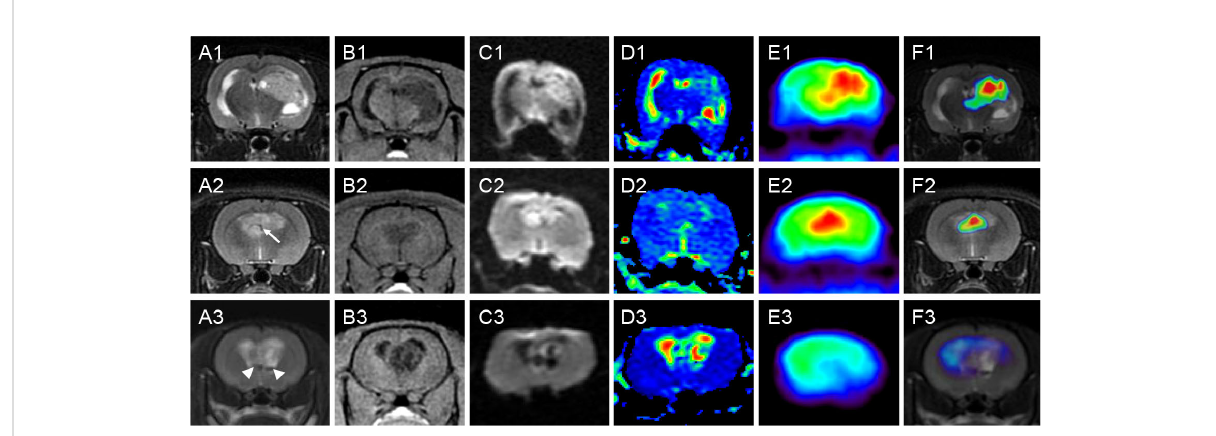
FIGURE 2 Characteristics of representative GSC tumors on MRI and PET. Rows 1-3 correspond to three nude rats with orthotopic xenograft tumors of GSCs. Columns (A – F) are coronal T2WI, 3D-FSPGR, DWI, ADC, PET and fusion map of T2WI and PET, respectively. All the three lesions presented low intensity on T1WI and high intensity on T2WI, and the intensity was inhomogeneous. Lesion in rat 1 was mainly presented as a solid tumor with cystic degeneration. Lesion in rat 2 was mainly presented as a patchy tumor with vasculature in the tumor (arrow). Lesion in rat 3 was mainly presented as a cystic tumor with component with very low intensity (arrowhead) on T2WI indicating remote hemorrhage. The boundaries were unclear and different levels of mass effect were found in all the three lesions. DWI images showed increased intensity in the solid or patchy tumor lesions (rat 1 and 2), but displayed decreased intensity in the regions of cystic degeneration (rat 3). PET also showed high uptake of 18 F-FDG in the solid or patchy tumor regions (rat 1 and 2), but showed low uptake in the cystic tumor (rat 3). GSC, glioma stem cell; MRI, magnetic resonance imaging; PET, positron emission computed tomography; T2WI, T2-weighted image; 3D-FSPGR, three-dimensional fast spoiled gradient-recalled sequence; DWI, diffusion weighted imaging; ADC, apparent diffusion coef fi cient; T1WI, T1-weighted image; FDG, fl uoro-2-deoxy-D-glucose.